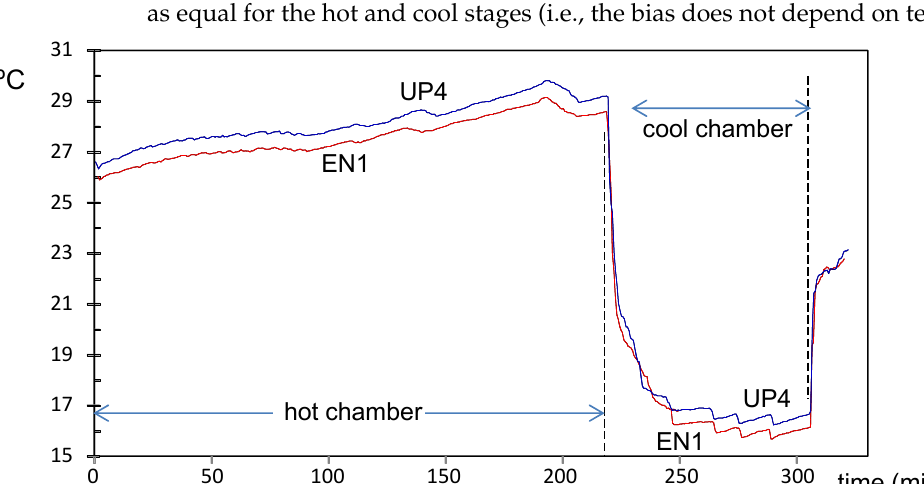
Figure 3. Trajectories of temperature during the calibration experiment, corresponding to nodes EN1 (in red) and UP4 (in blue). A parallel pattern is observed both for the hot and cool stages.